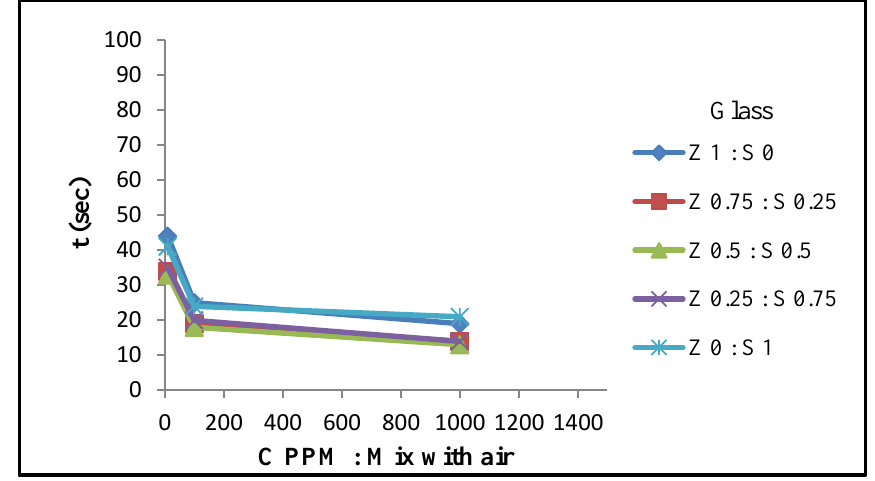
Fig. 18: Response time of Z:S mixed ratio for H